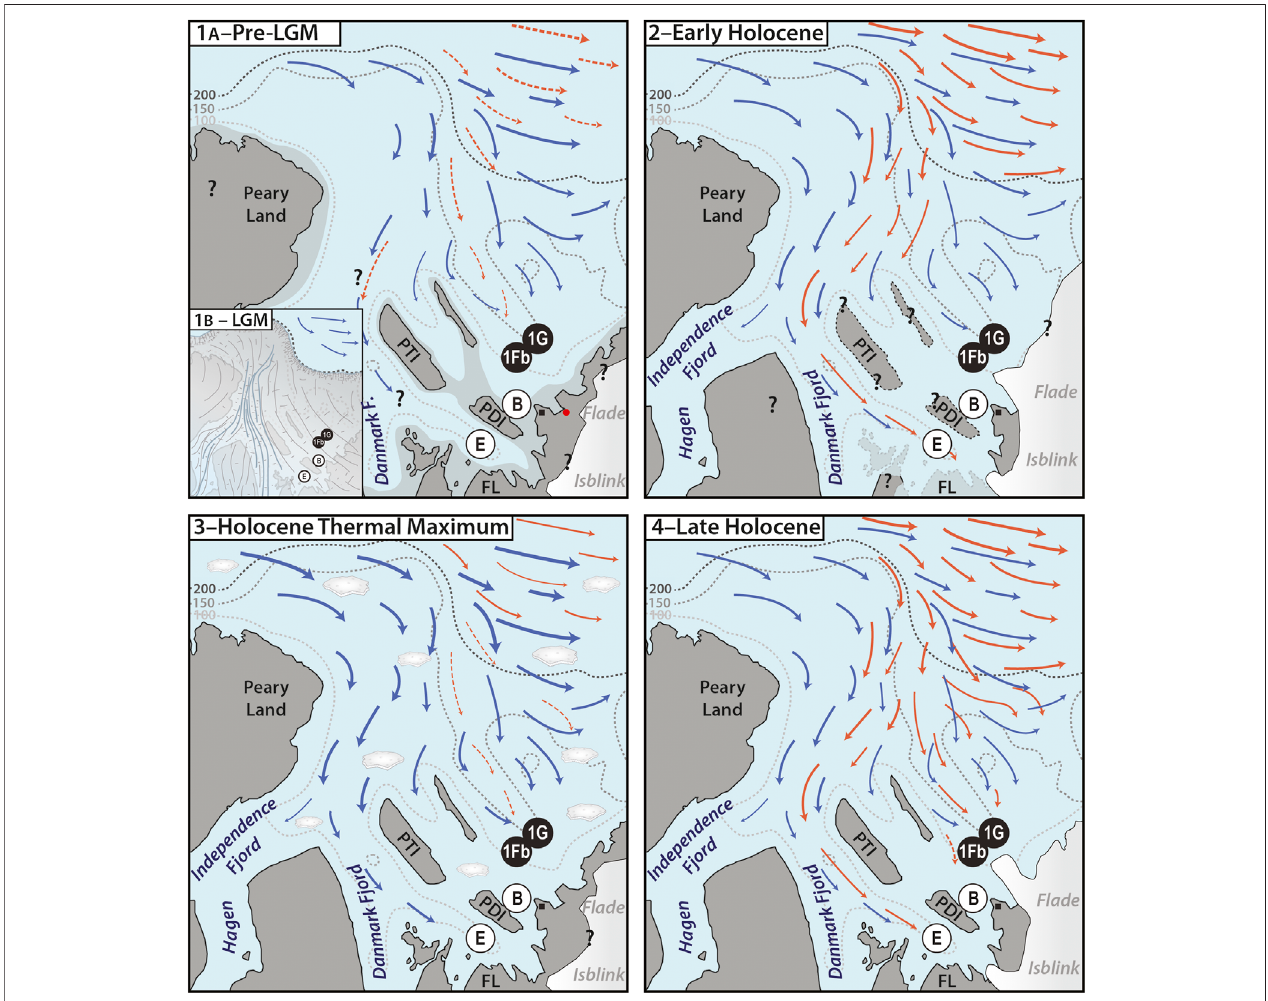
FIGURE4| Schematicrepresentation ofwaterin fl owintotheIndependenceFjordsystemduring thepastca.50 kyrasdiscussed inthetext. The dottedgray lines represent the present-day 100, 150, and 200 m isobaths based on Nørgaard-Pedersen et al. (2008) and Dmitrenko et al. (2017) – note that these are to a large extent approximate since much of the area has not been covered by detailed bathymetric surveys. Orange arrows indicate Atlantic-sourced subsurface waters, blue arrows indicate polar surface waters, striped lines suggest occasional, intermittent in fl ow only. The black circles show the position of sites 1Fb and 1G studied here, the white circles show the position of sites E and B from Nørgaard-Pedersen et al. (2008), the black square shows the location of Station Nord. PDI (cid:1) Prinsesse Dagmar Island, PTI (cid:1) Prinsesse Thyra Island, and FL (cid:1) Finderup Land. The question marks in the scenarios relay the fact that much still remains unknown about the latest Pleistocene – Holocene history of the area. (1A – Pre-LGM) Low but indicative numbers of dinocysts and/or calcareous benthic foraminifera, the latter having a radiocarbon age of at least 30 kyr, in the bottom sections of long cores from sites 1Fb and 1G, and reworked marine mollusc shells radiocarbon-dated to ∼ 52.7 to 43.1 ka BP recovered from a location (red dot) near one of the modern-day Flade Isblink outlet glaciers (Larsen et al., 2019), suggest episodic in fl ow of Atlantic-sourced waterstothenortheastofPDIatoneorseveraloccasionsduringtheMiddleWeichselian.Thereisnoinformationavailableaboutwhetherornotthesewatersalso fl owed to the west of PTI and PDI. The light-shaded gray suggests an approximate outline of exposed terrain during the Middle Weichselian based on the present-day bathymetry and a ca. 75 m sea-level drop (e.g., Spratt & Lisiecki, 2016), but Middle Weichselian global sea level might have dropped 30 – 40 m less than that (Pico et al., 2016; Batchelor et al., 2019). (1B – LGM, inset) The Independence Fjord system is covered by the Greenland Ice Sheet extending onto the outer Wandel Sea shelf. (2 – Early Holocene) Steered by topography and the possibly slightly earlier deglaciation of the western fjord, Atlantic-sourced waters penetrate between Peary Land and PTI toward site E (Nørgaard-Pedersen et al., 2008) and across isostatically depressed FL (Strunk et al., 2018; Larsen et al., 2019). There is no evidence for Atlantic- sourced waters also reaching sites B, 1Fb and 1G during the early Holocene. (3 – Holocene Thermal Maximum) Despite reduced ice cover along the east coast of Greenland (Funder et al., 2011b), in fl ow of Atlantic-sourced waters, if any at all, is intermittent and strongly suppressed. Under a positive Arctic Oscillation with strengthened and eastward-shifted Transpolar Drift, the water column at the fjord mouth might have been fl ooded by polar waters, furthermore bringing along ice fl oes from the Arctic that can freely drift into the fjord system and hamper primary production. Note that ice fl oes are shown in this cartoon only to emphasize their suggested increasedpresenceandeffectduringtheHoloceneThermalMaximumwithrespecttotheothertimeintervals. (4 – LateHolocene) Atlantic-sourcedwatersmakeupthe subsurface water column in the deeper parts of the Independence Fjord system including sites E, 1G and 1Fb in modern times. The in fl ow appears to have started at least 2,000 years ago and gradually increased over that time, on occasion also in fl uencing site B.